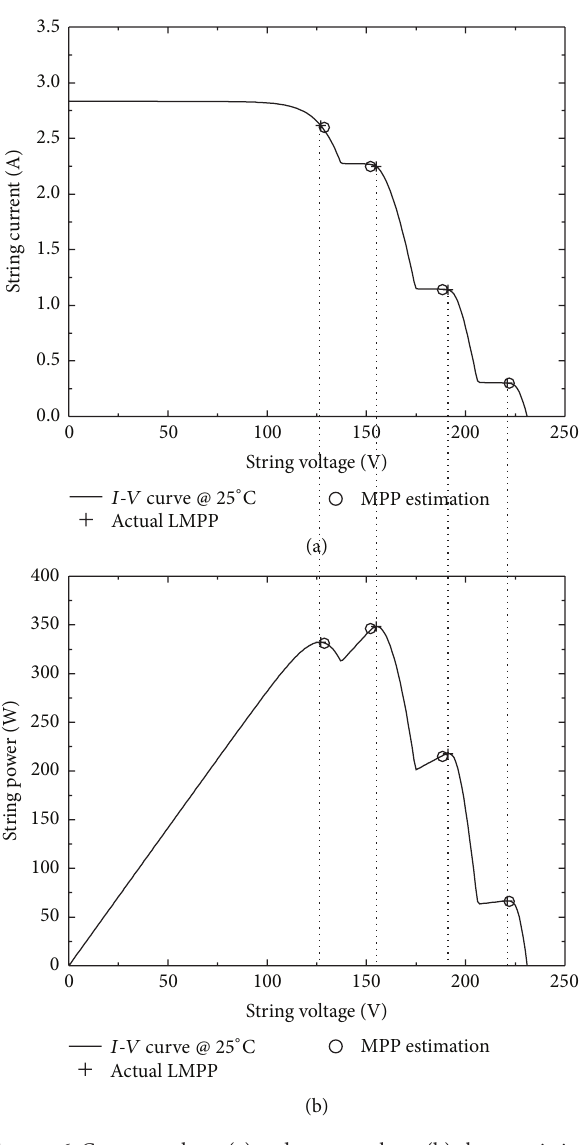
Figure 6: Current-voltage (a) and power-voltage (b) characteristics. The actual local maxima (crosses) and the maxima estimated by means of information based MPPT algorithm (circles) are also reported.